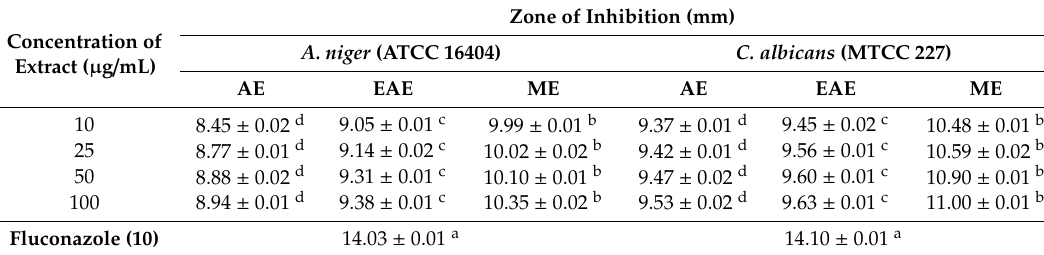
Table 9. Activity of di ff erent M. esculenta leaves extracts against fungal